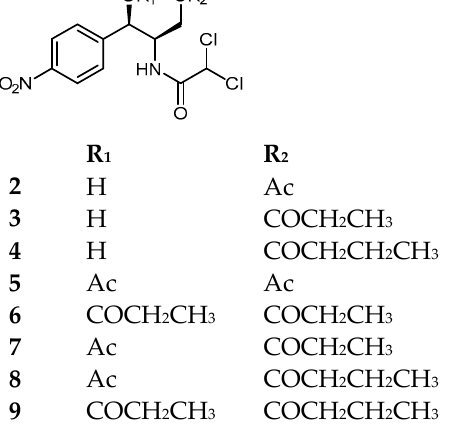
Figure 2. Structures of chloramphenicol (CAM) derivatives discovered by functional meta- genomics.